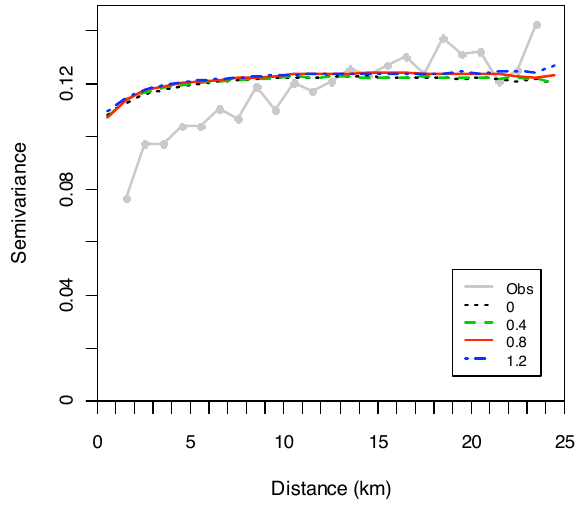
Fig. 8. Cumulative distribution function (CDF) of non-zero rain- fall rates from all observations, of the subset of 2000 15-min in- tervals used to initialize the large-scale rainfall R 0 for the simu- lations, and of the simulations. Simulated rainfall was generated using log-normal Models SI σ /RI σ /LN, SD σ /RI σ /LN with γ =0.8, SI σ /RD σ /LN, and SD σ /RD σ /LN with γ